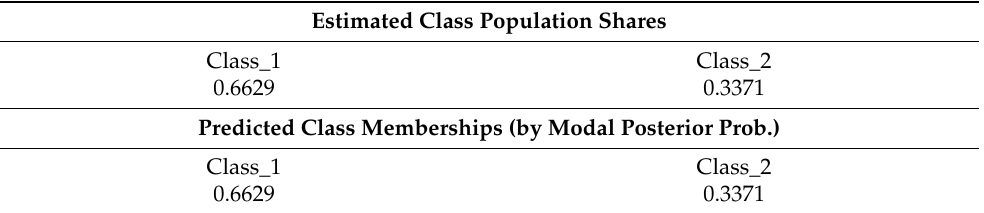
Table 7. Estimated class population shares and predicted class memberships (by modal poste- rior